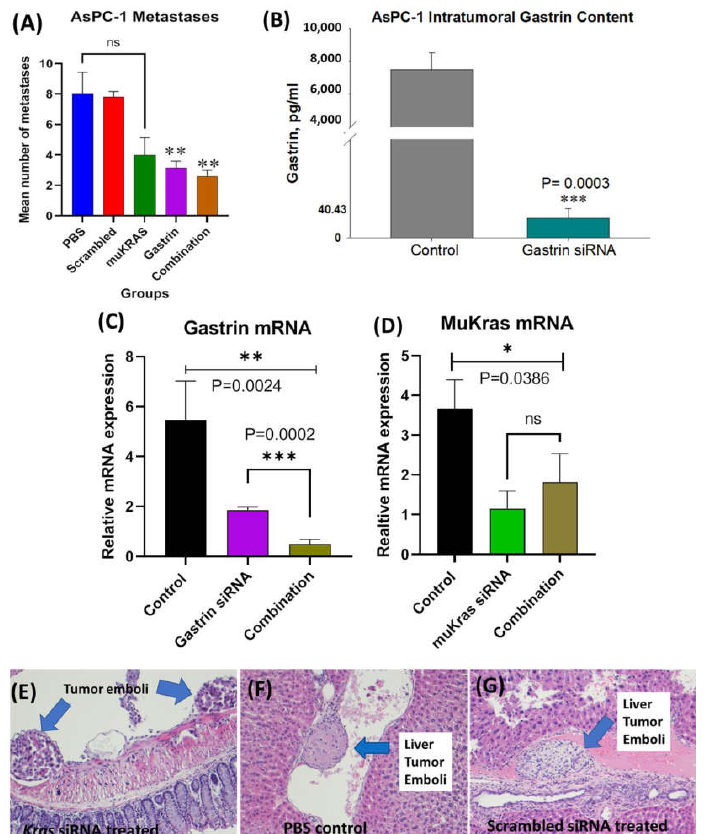
Figure 4. Effects of CCK-BR targeted NP on metastases in human pancreatic cancer in AsPC-1 tumor bearing mice. ( A ) Mean number of metastases per mouse is shown. Mice treated with PBS and the scrambled siRNA NP had the greatest number of metastases. MuKRAS siRNA-treated mice had fewer metastases but not statistically significant ( p < 0.06). However, both groups treated with the NP delivering the siRNA to GAST had fewer metastases ( p < 0.02). ( B ) Gastrin peptide in tumor homogenates measured by ELISA show less gastrin peptide in tumors of mice treated with GAST siRNA NPs ( p = 0.0003). ( C ) Tumors were excised and gastrin mRNA expression was confirmed to be down-regulated by qRT- PCR ( p = 0.0024). ( D ) MuKRAS mRNA expression levels in tumors of mice treated with the muKRAS siRNA loaded NP is lower than that of control tumors. ( E ) H&E image of tumor emboli seen adjacent to the colon in a muKRAS siRNA treated mouse. ( F ) A tumor emboli is identified in a central vein in a liver section from a PBS-control treated mouse. ( G ) Tumor emboli identified in a hepatic vein of a mouse treated with a scrambled siRNA loaded NP, (scale bar = 200 µ m). * p < 0.05; ** p < 0.01; and *** p <